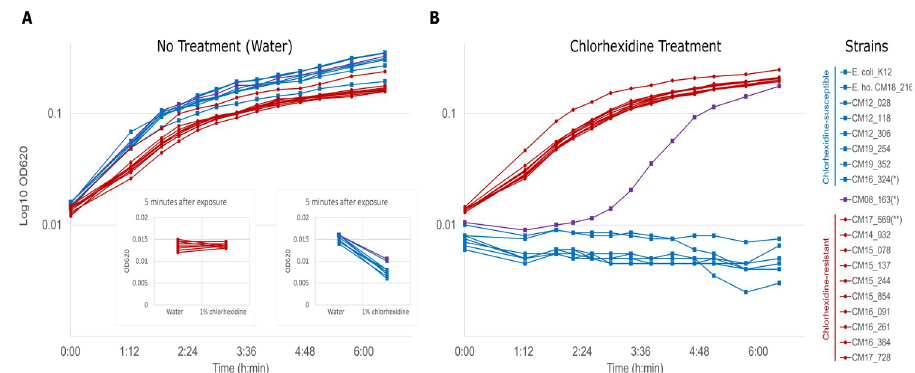
Fig 3. Effect of chlorhexidine exposure on the growth of Serratia isolates from the U-Vet, indicating the ability of the resistant strains to recover from routine disinfection protocols. Duplicate cultures of each isolate were incubated in a 96-well plate. The average of the two OD620nm values after blank subtraction are plotted against time on a log-transformed scale. The single asterisk � indicates S . ureilytica isolates. A: Bacterial suspensions exposed to sterile water for 5 minutes, then diluted 1:10 in Letheen Broth. B: Bacterial suspensions exposed to 0.5% chlorhexidine for 5 minutes, then diluted 1:10 in Letheen broth. Red lines, filled circles: Chlorhexidine-resistant Serratia isolates including all 9 MDR isolates and the non-MDR strain CM2017_569 (double asterisk �� ). Blue lines, filled squares: Chlorhexidine-susceptible Serratia strains, E . hormachei strain CM2018_216, and control strain E . coli K12. Purple line, filled squares: S . ureilytica strain CM2008_163, showing intermediate resistance to Chlorhexidine. Insets indicate the OD620nm values shortly after the dilution step in Letheen broth (time 0).